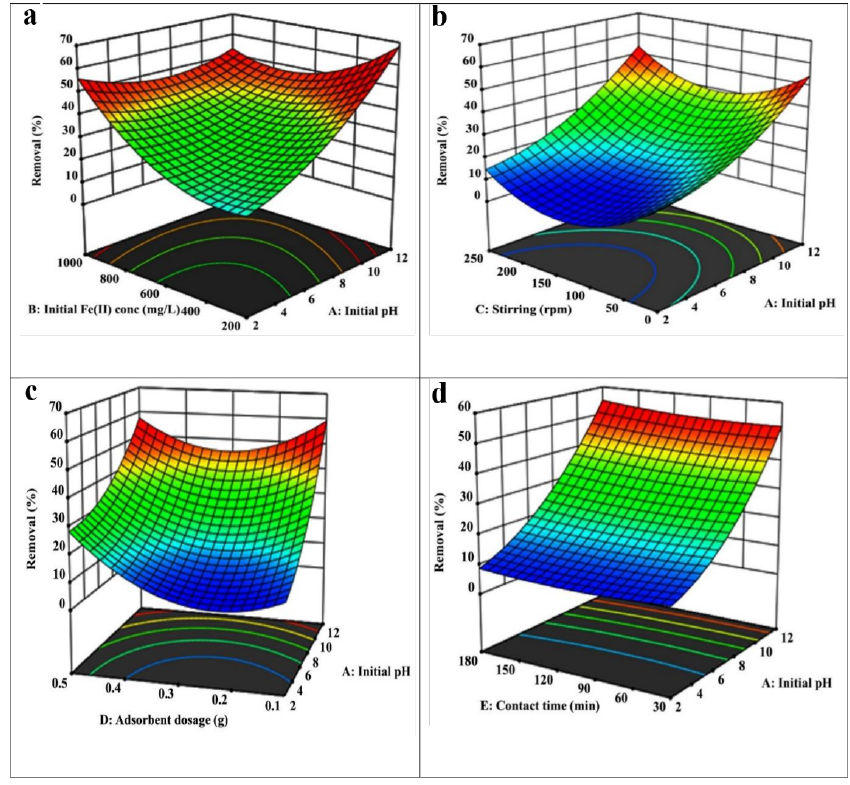
Fig. 4. Some effects of the factors studied on the efficiency of Fe(II) removal : a) at 0.18 g adsorbent dosage, 0 rpm stirring speed, and 105 min contact time; b) at 432 mg/l initial Fe (II) concentration, 0.15 g adsorbent dosage, 75 min contact time; c) at 280 mg/l initial Fe (II) concentration, 75 rpm stirring speed, 105 min contact time; d) at 200 mg/l initial Fe (II) concentration, 75 rpm stirring speed, 0.3 g adsorbent dosage.